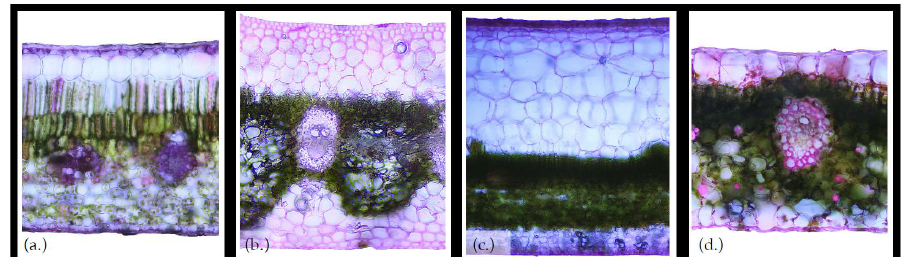
Figure 2. Cross sections of common vascular epiphyte leaves highlight variation in the water storage cell structure. ( a ) Oreopanax anomalus , a woody epiphyte, has large epidermal cells on the upper side of the leaf that likely function in water storage, and hydrenchymal cells on the underside of the leaf. The bromeliad, ( b ) Werauhia werckleana , has distinctive hydrenchymal layers on both sides of the leaf that comprise most of the cross-sectional area. ( c ) Clusia palmana , a woody hemiepiphyte, has a hydrenchymal layer on the upper side of the leaf with cells that are much larger than cells in the rest of the leaf, as well as smaller hydrenchymal cells on the underside. ( d ) Stenospermation sessile , an herbaceous epiphyte, does not have a distinct hydrenchymal layer; however, the oversized epidermal cells likely function in water storage and there are hydrenchymal cells interspersed throughout.